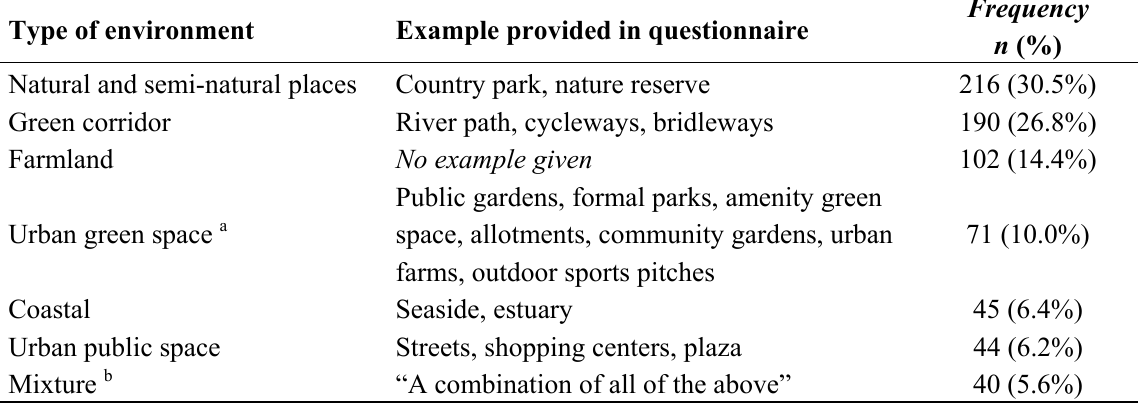
Table 1. The number of frequently attending Walking for Health (WfH) walkers as a function of the main type of environment in which walked with their WfH group ( n =